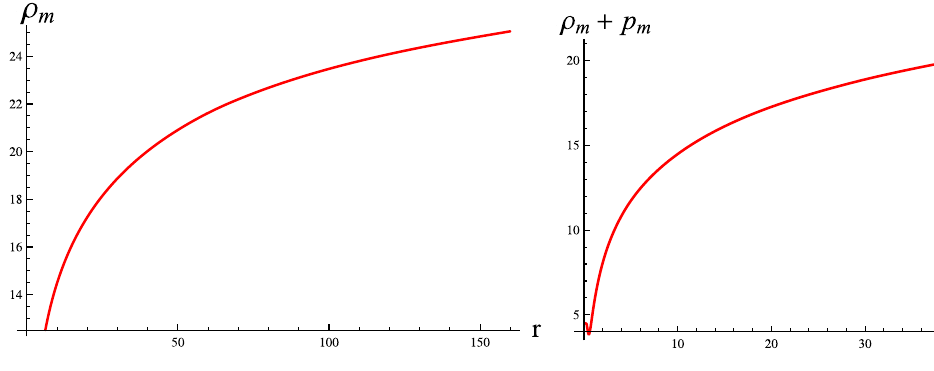
Fig. 11 Evolution of energy bounds versus r for w = −